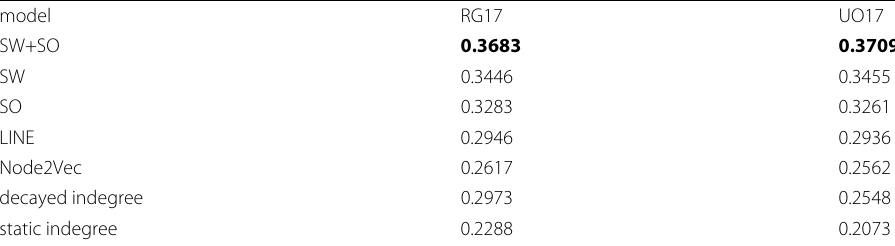
Table 4 Best mean global performance (NDCG@100) of each model for the Twitter tennis data sets